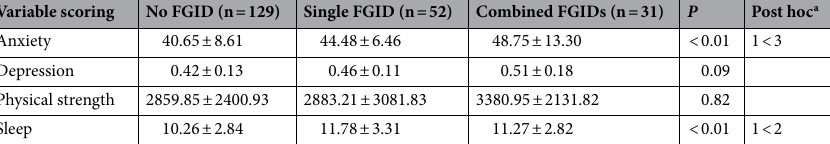
Table 4. Comparison the psychological scoring among the participants. a Post hoc analysis was used LSD test, 1,2, AND 3 represents no FGID group, Single FGID group and Combined FGIDs group, respectively.